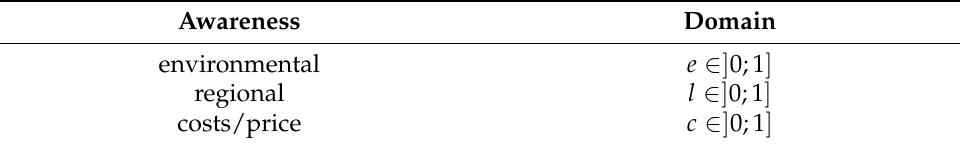
Table 4. Domains of consumer preferences.